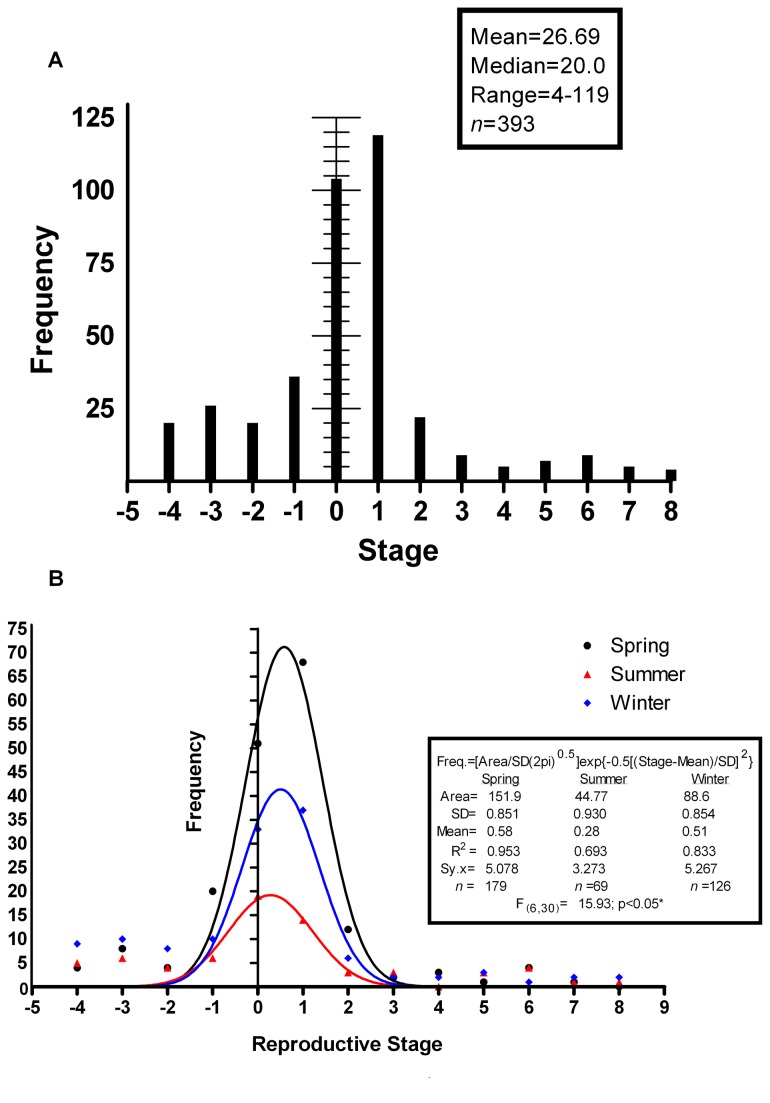
Reproductive status and seasonal patterns.(a) A frequency histogram for the reproductive stages introduced in Table 1. The majority of animals sampled in this study were either sexually undifferentiated or in the earliest stages of female gonadal development. (b) A seasonal comparison of the distribution of reproductive stages. The general pattern of distribution is similar in all seasons. Spring differs from other seasons in area but Spring, Summer, and Winter do not differ in Mean and SD.